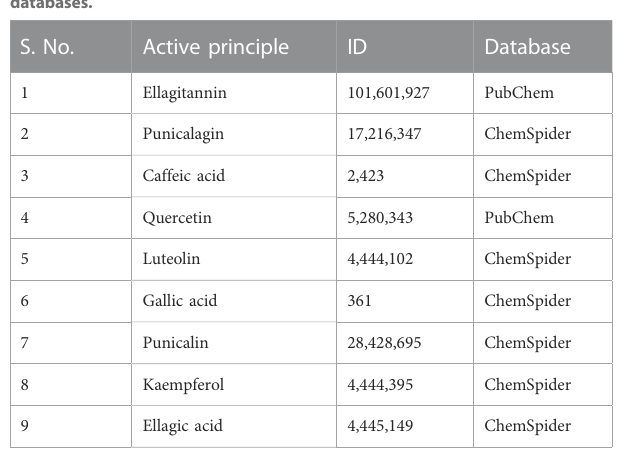
CYP3A4 – punicalagin (7,742 atoms) and CYP3A4 – ellagitanin